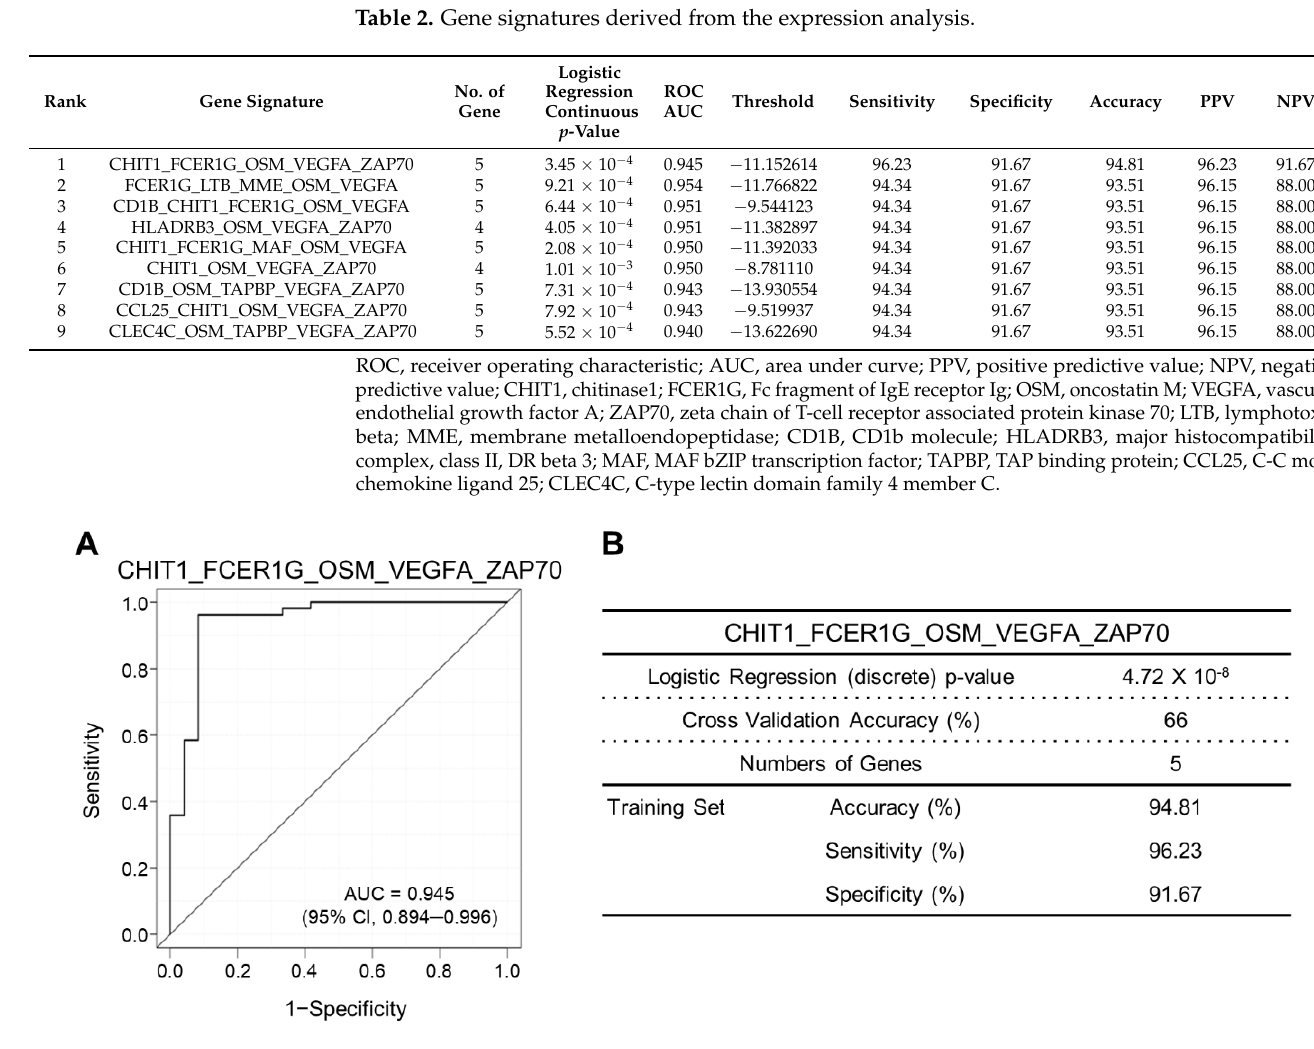
Figure 2. Clinical performance evaluation of the selected 5-gene signature. The clinical performance of the 5-gene signature was evaluated using receiver operating characteristic (ROC) analysis, cross- validation, and logistic regression analysis. ( A ) ROC analysis of 5-gene signature to the advanced fibrosis stage. ( B ) Clinical performance of the 5-gene signature in logistic regression analysis, cross- validation, and ROC analysis.